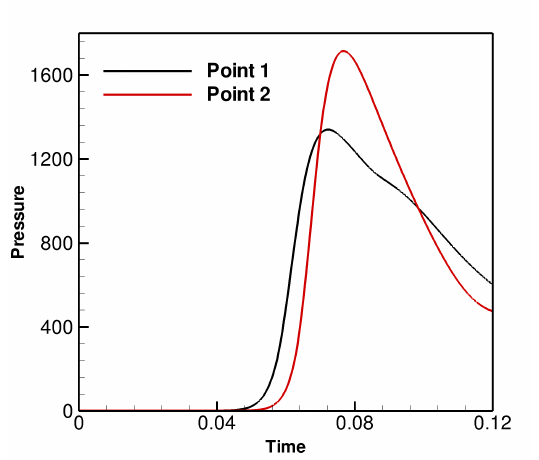
Figure 9. The pressure history recorded at the boundaries of the computational domain for an initially cuboid-shaped bubble (Scenario